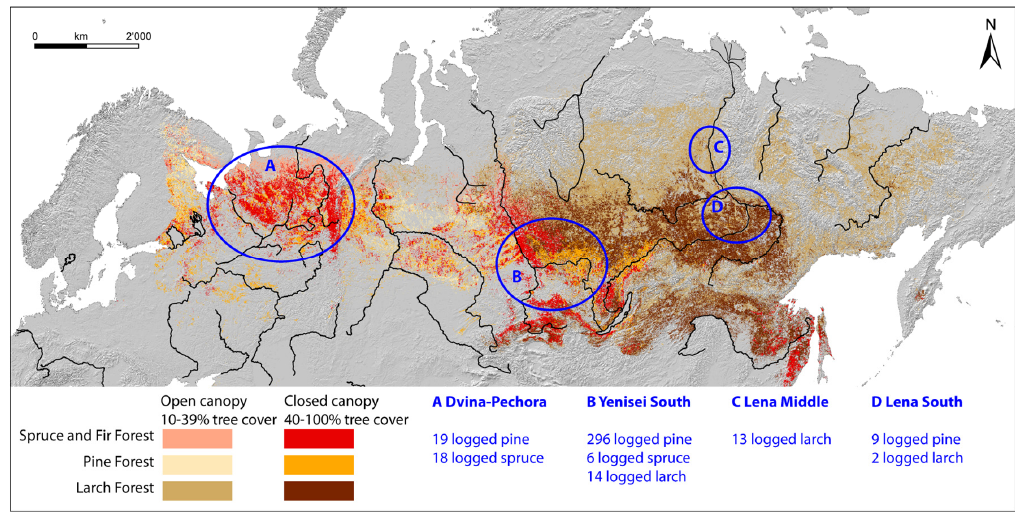
Figure 3. Dominating forest types of spruce/fir, pine and larch for Russia (adapted from [38]). Blue circles indicate the regions to which logged driftwood samples of pine, spruce and larch from sub-Arctic and Arctic islands have been dendro-provenanced to with at least ten samples for the three species.